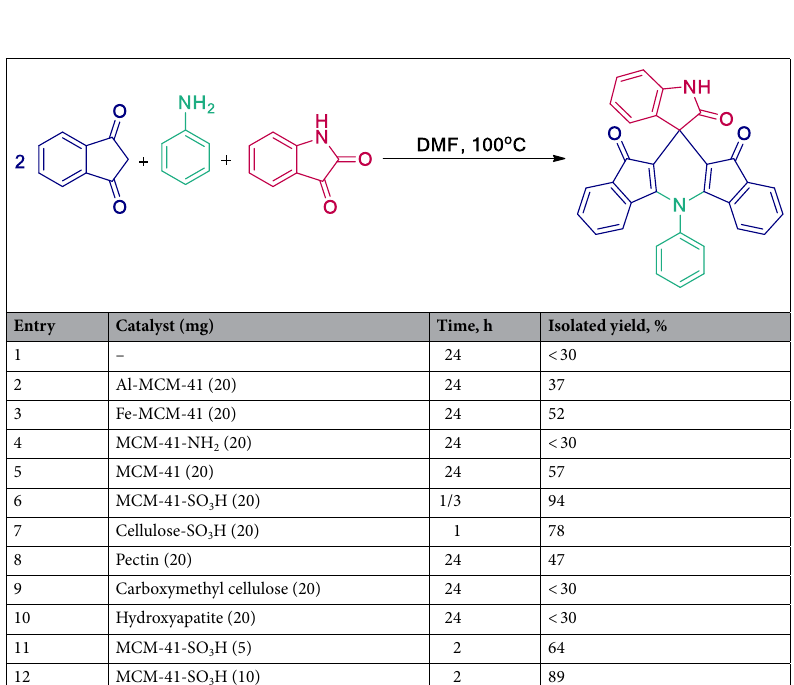
Table 1. The evaluation of activity of different catalysts in the model reaction. Reaction conditions: isatin (1 mmol), 1,3-indanedione (2 mmol), aniline (1 mmol) and DMF (1 mL) at 100